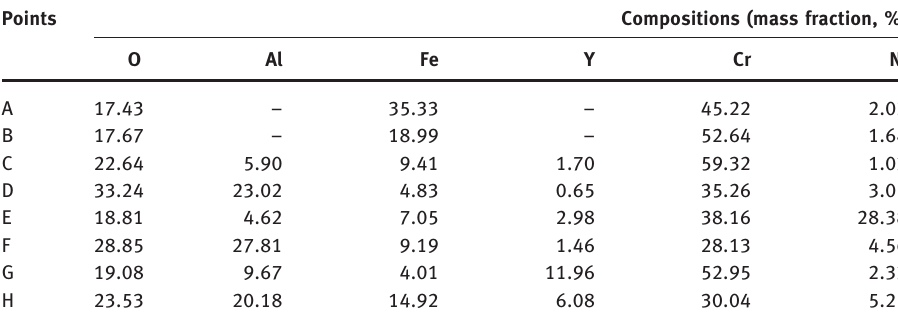
Table 1: EDX analysis of the points A, B, C, D, E, F, G and H marked in Figure 5.